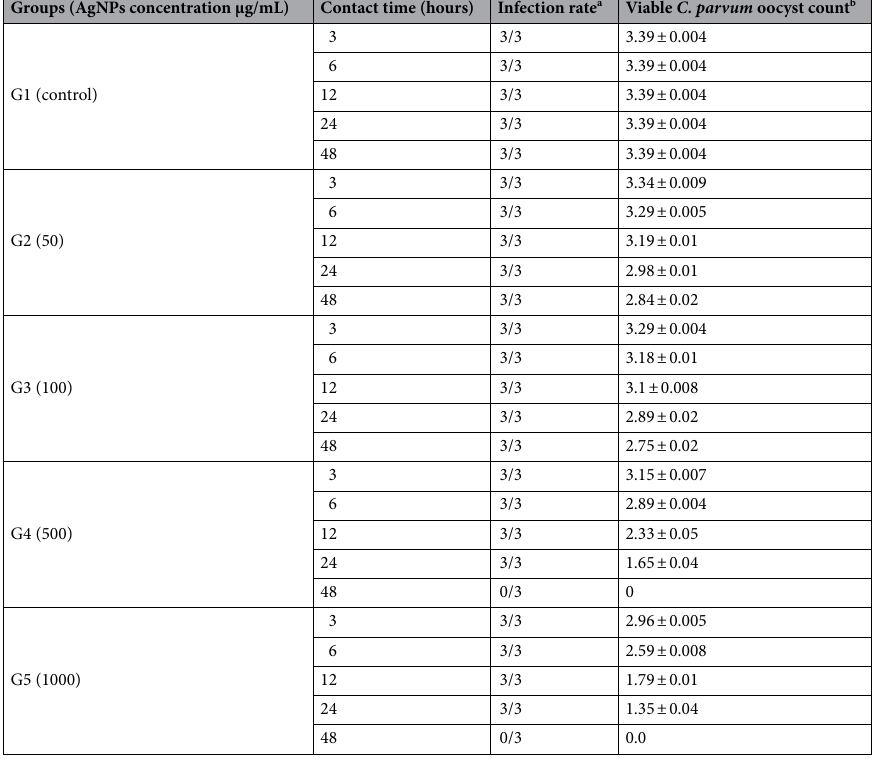
Groups (AgNPs concentration µg/mL) Contact time (hours) Infection rate a Viable C. parvum oocyst count